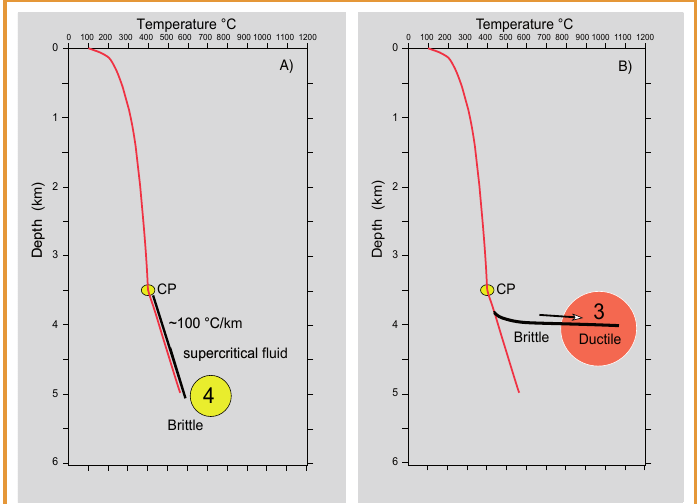
Figure 6. Two temperature scenarios for drill holes around a cooling intrusion at Krafla: [A] along the margin and [B] into a cooling magma body at ~4 km